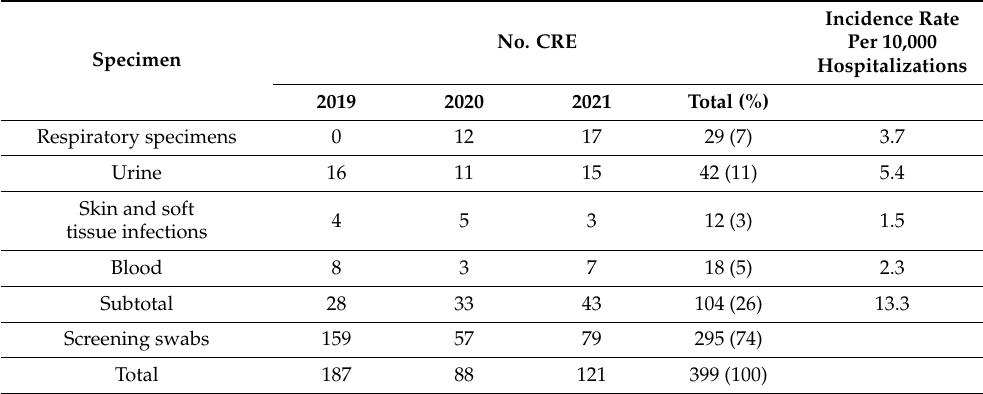
Table 1. Distribution of clinical specimens of